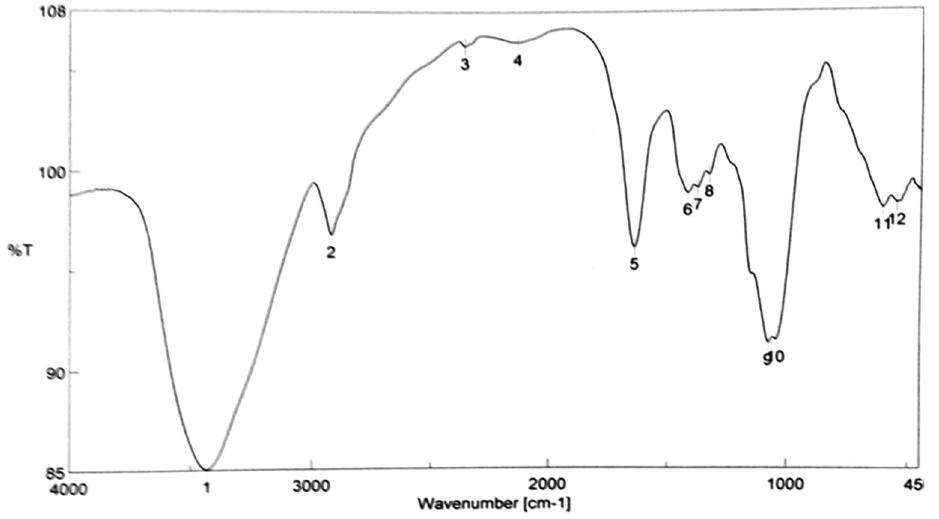
Figure 2. FT-IR spectrum of PsPc-3 from Pleurotus